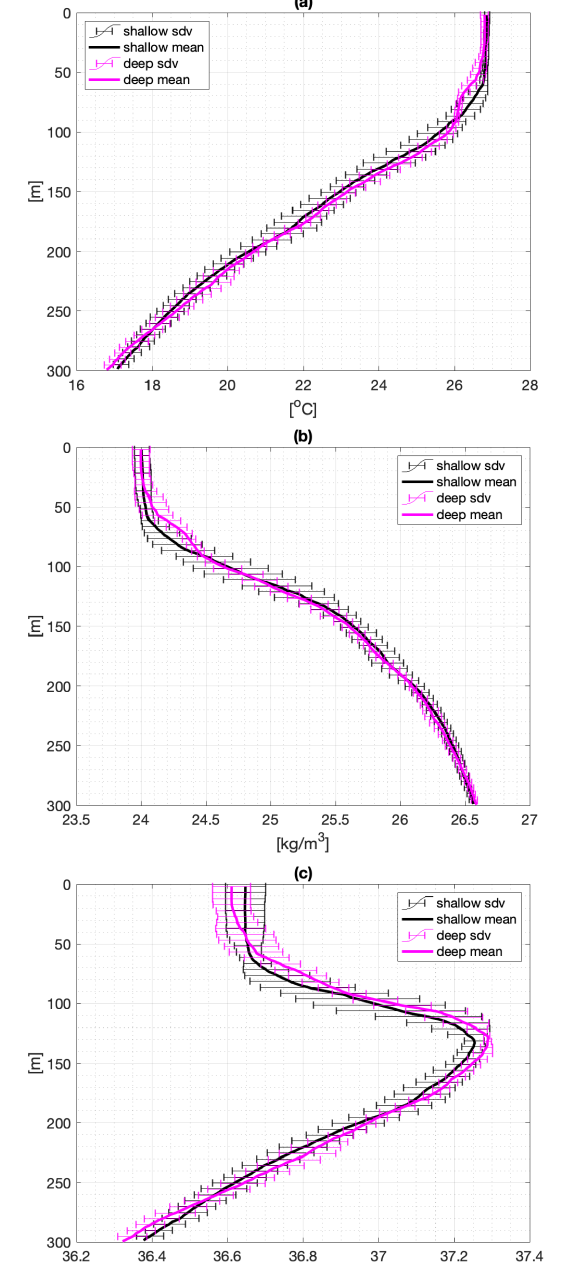
Figure 8. Standard deviations for shallow and deep station profiles: ( a ) Temperature, ( b ) Density, and ( c )